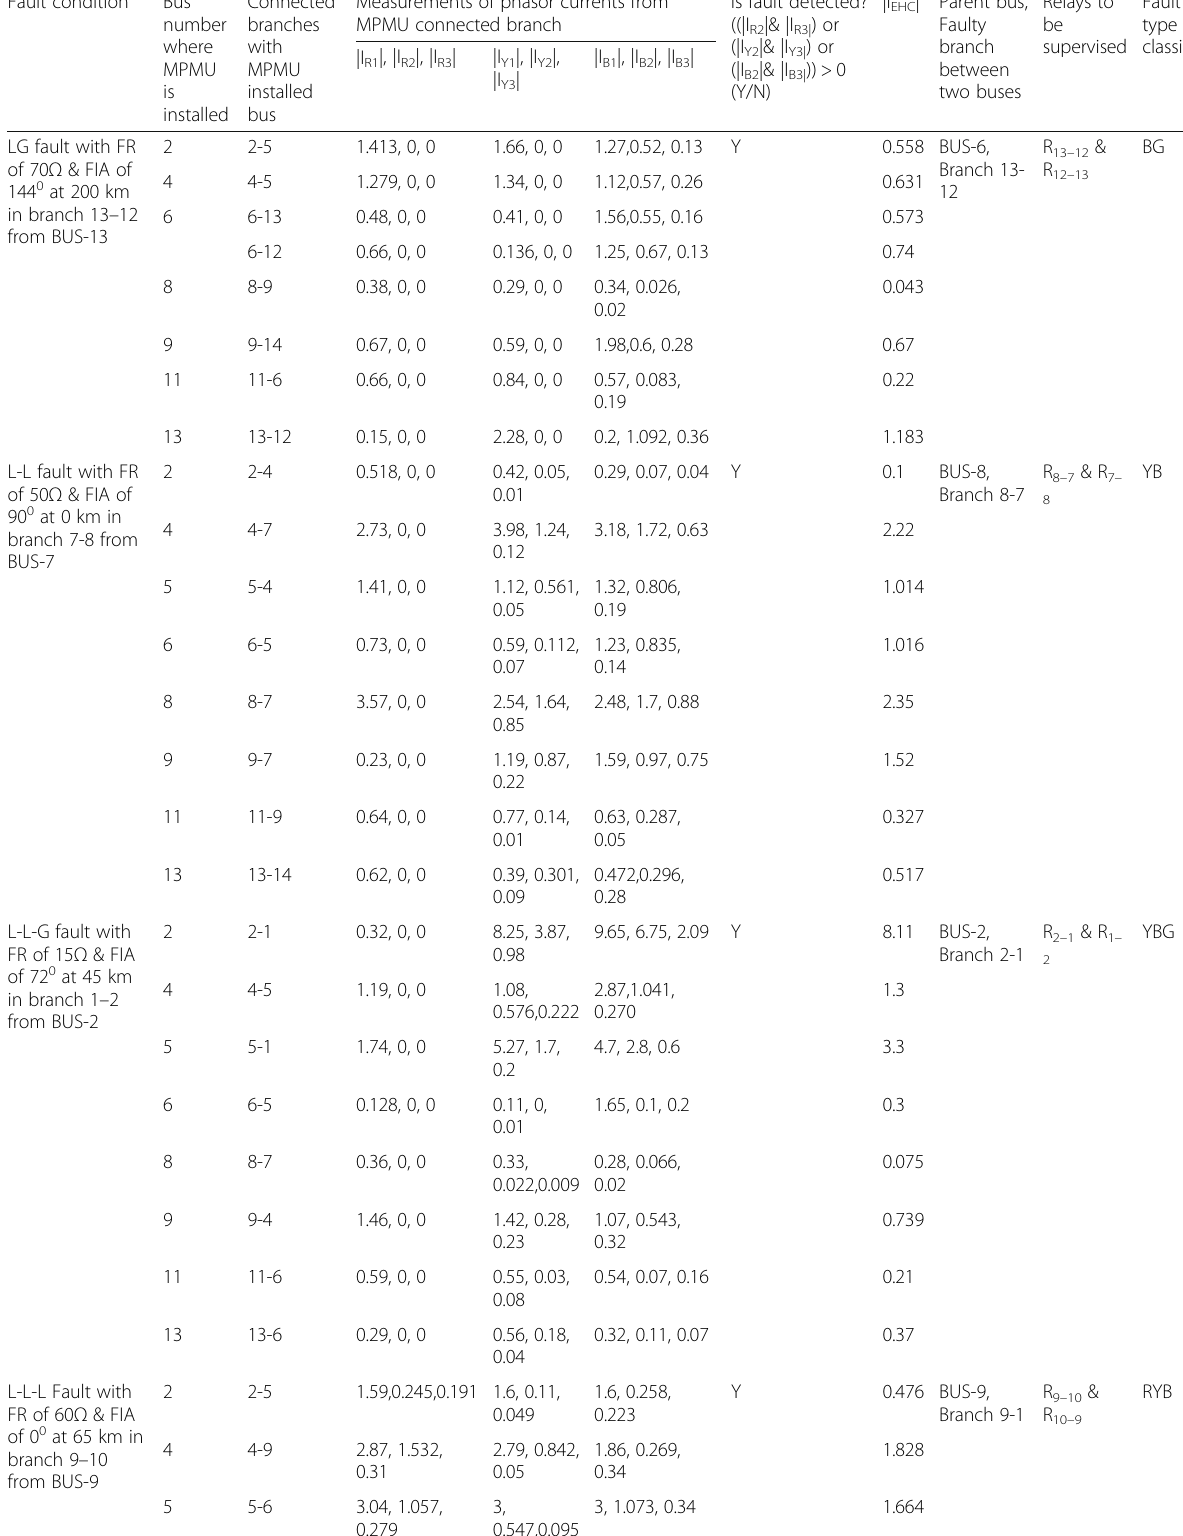
Table 3 Results of case studies conducted on IEEE-14 bus system under various transmission line